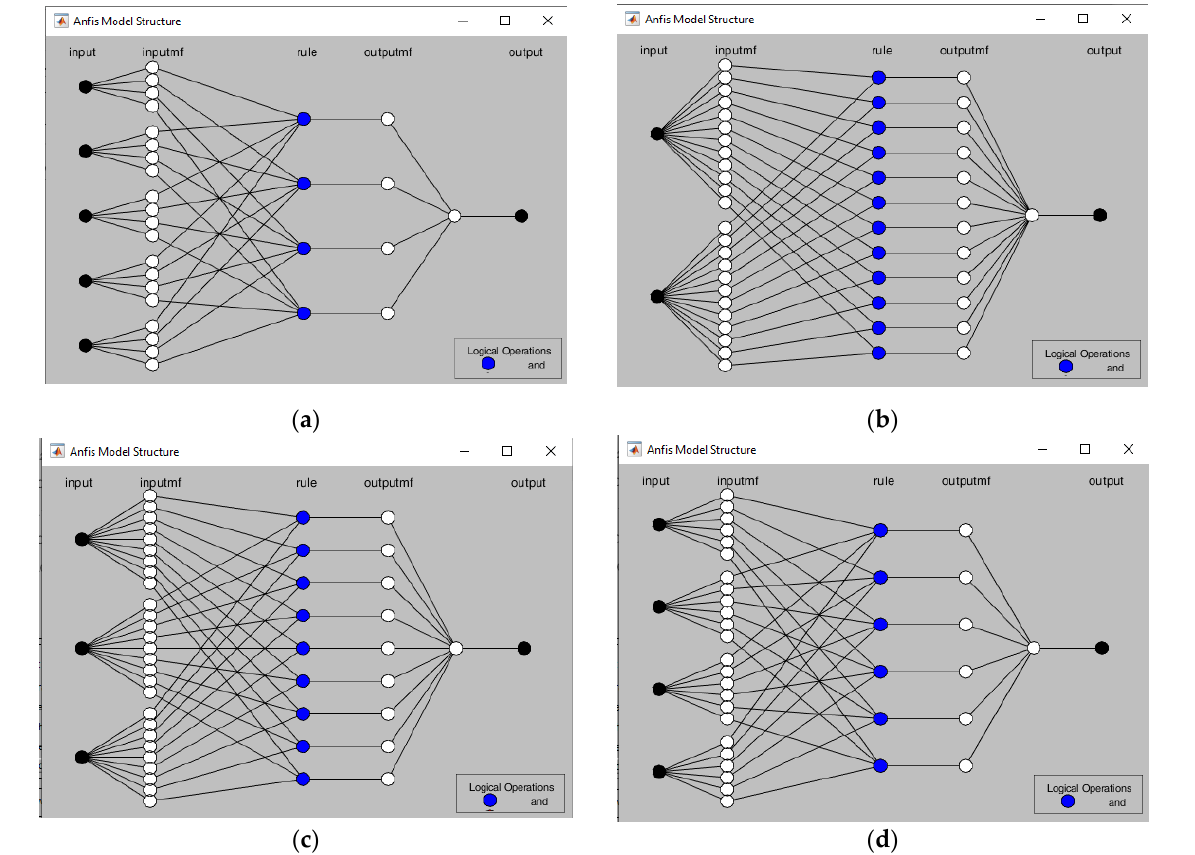
Figure 14. Different models of ANFIS FCM: ( a ) N = 5, C = 4; ( b ) N = 2, C = 11; ( c ) N = 3, C = 9 ( d ) N = 4, C = 6. Table 3. Results of modelling and prediction using the ANFIS FCM.